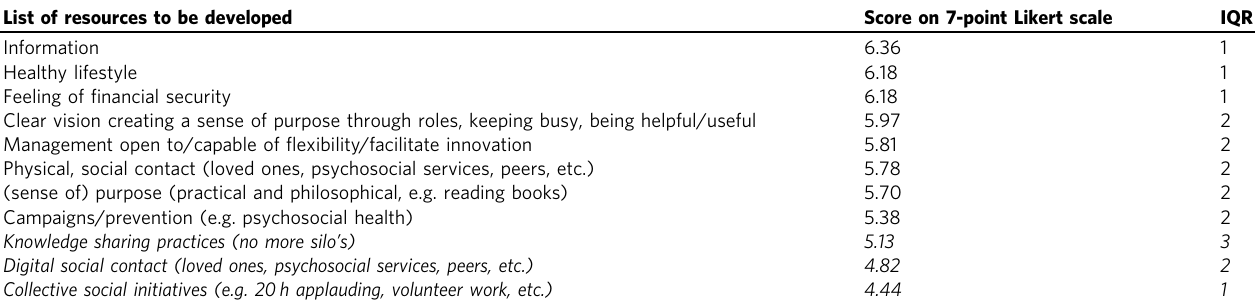
Table 5 Resources experts indicate as useful to be further developed during a pandemic in order to deal with the psychosocial consequences of the pandemic — no consensus indicated in italics.